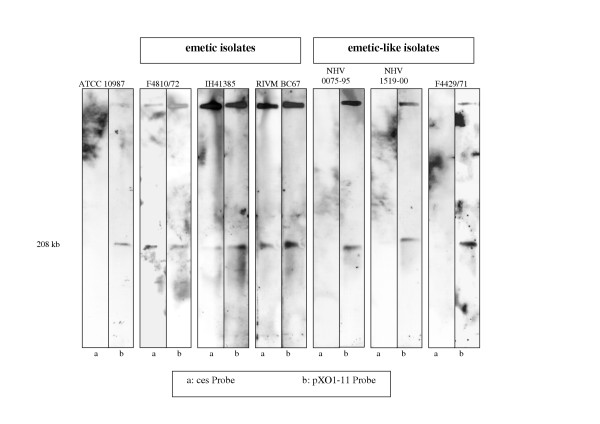
Hybridization of emetic and emetic-like B. cereus with probes targeting the ces operon (a) and a pXO1 related CDS (b). Total DNA was separated by PFGE, transferred to a membrane and hybridized with a cesB specific probe and a probe derived from pXO1-11 (for details on probes see Supplemental Materials Table S1). Hybridization with both probes revealed a single band for emetic strains which has the same size as the pBc10987 plasmid from B. cereus ATCC 10987 (lane 2).